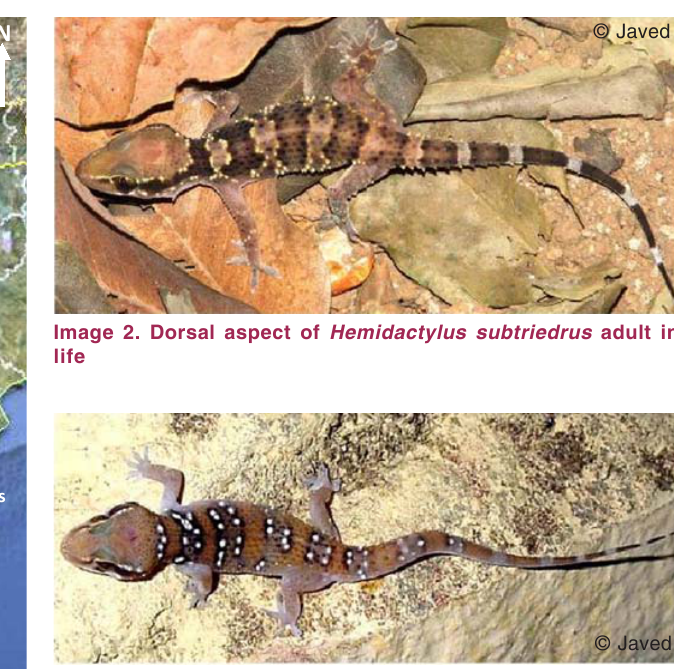
Image 3. Dorsal aspect of Hemidactylus triedrus adult in life